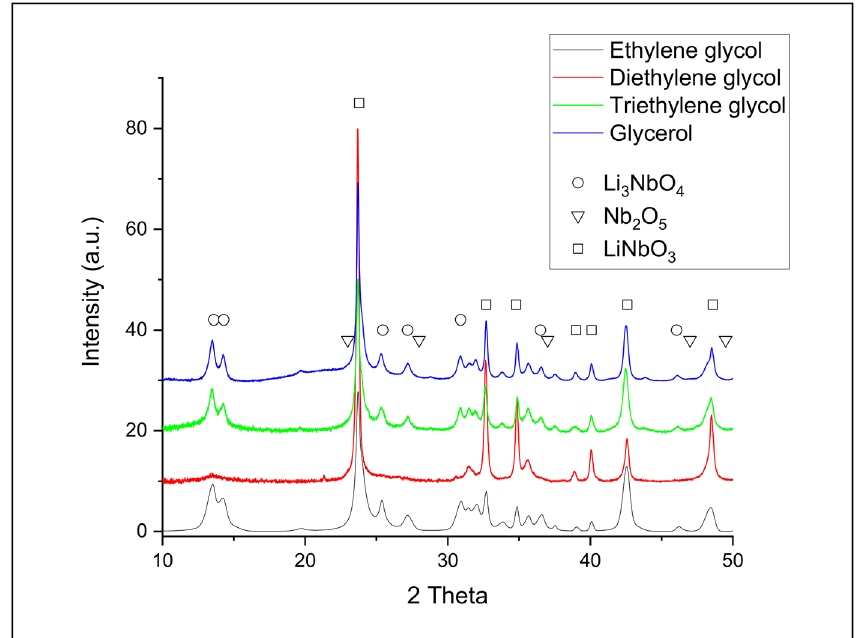
Figure 5. Effect of the polyol medium for the chemical synthesis of LN as shown by the XRD diffractograms ( r = 1 and all samples were treated for 72 h).